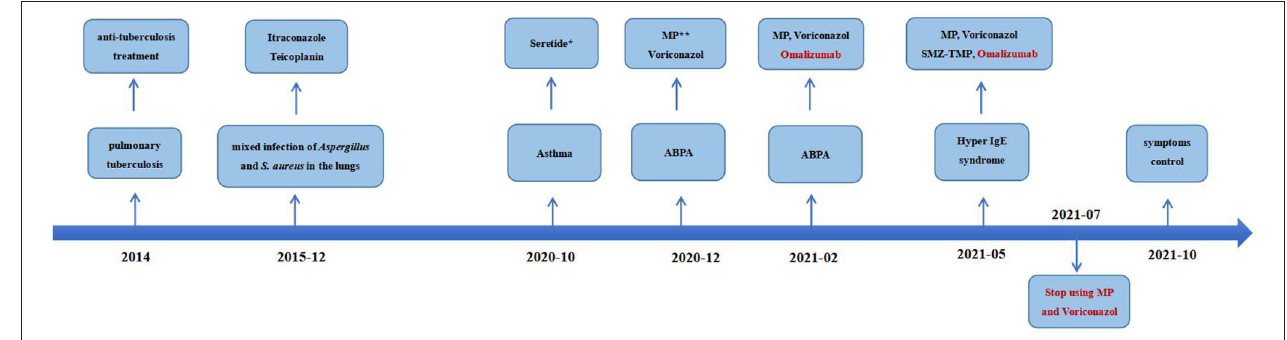
FIGURE 2 | Time-line with the most relevant data of the clinical case.*Salmeterol Xinafoate and Fluticasone propionate powder for inhalation.